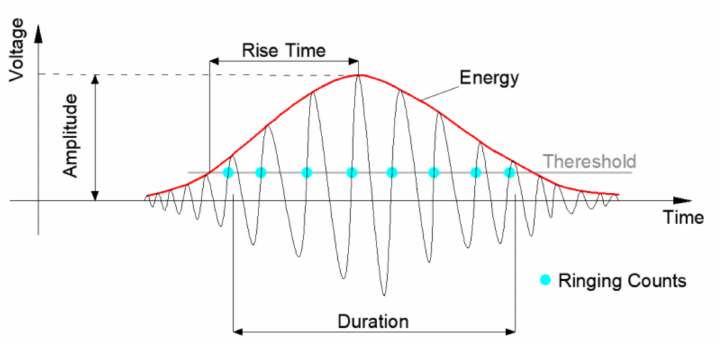
Figure 1. Acoustic emission (AE)